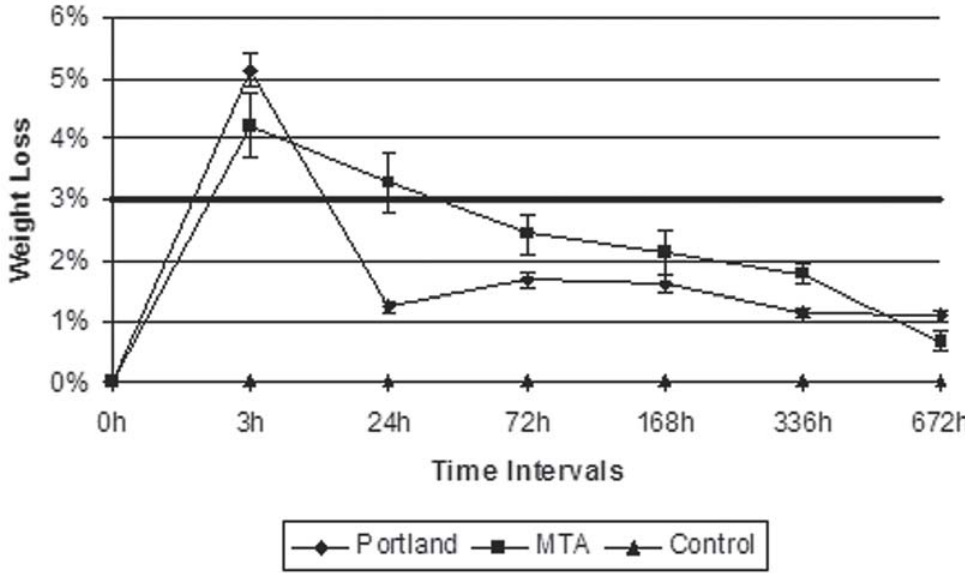
FIGURE 2- Mean weight loss ± standard error of mean of the cements during the experimental intervals determined by the residue collection method. The bold horizontal line represents the requirement for compliance with the ISO 6876 standard TABLE 1- Three-way ANOVA for the comparison between methods, cements and time (M – methods; C – cements; Ti – Time; * statistically significant)